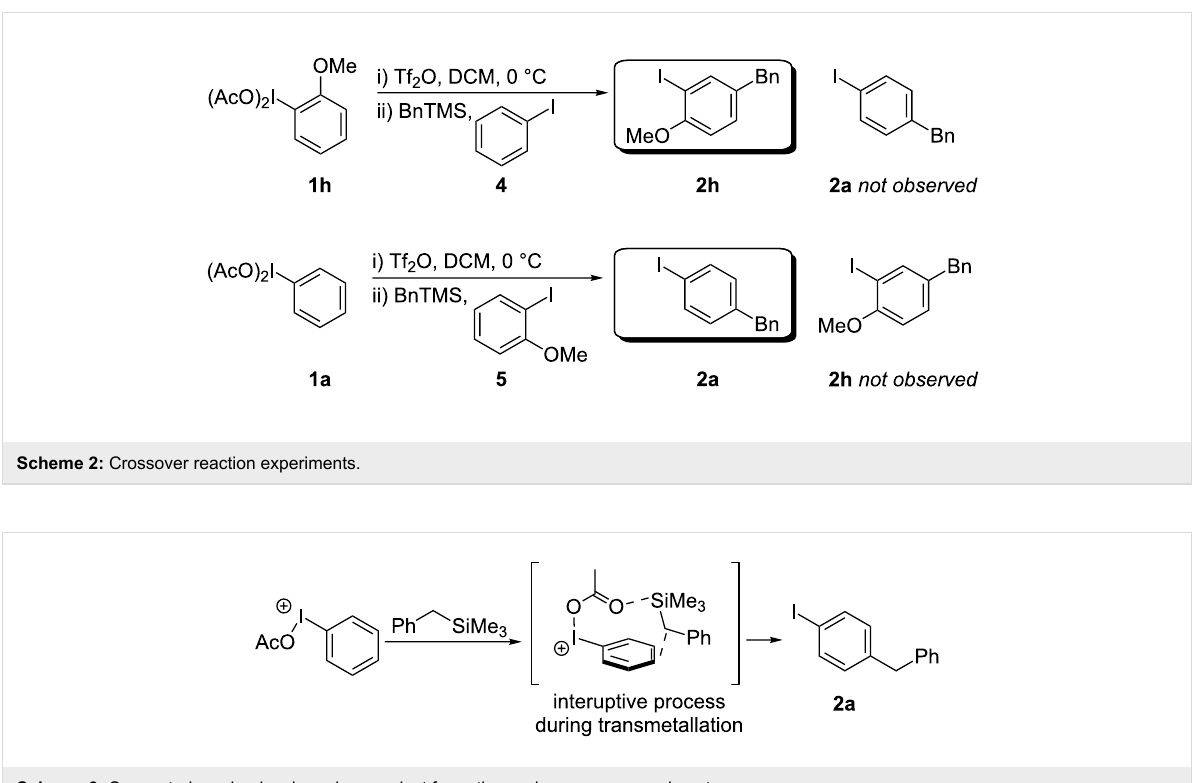
Scheme 3: Suggested mechanism based on product formation and crossover